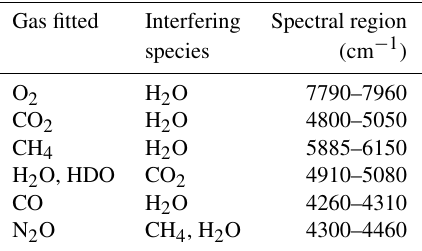
Table 1. Summary of the spectral windows used for retrieval of path-averaged concentrations in the open-path NIR spectra; see Griffith et al. (2018) for plots.